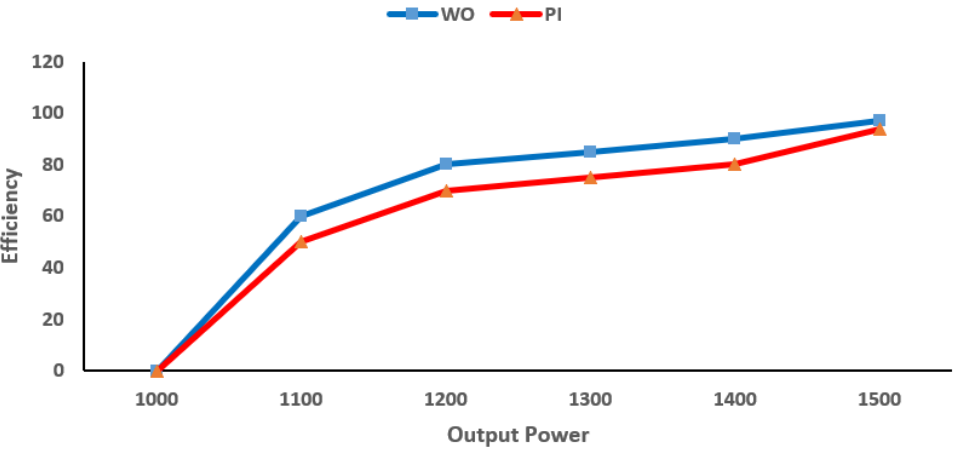
Figure A3. Comparison of conventional and optimized proportional-integral controllers of the proposed converter.